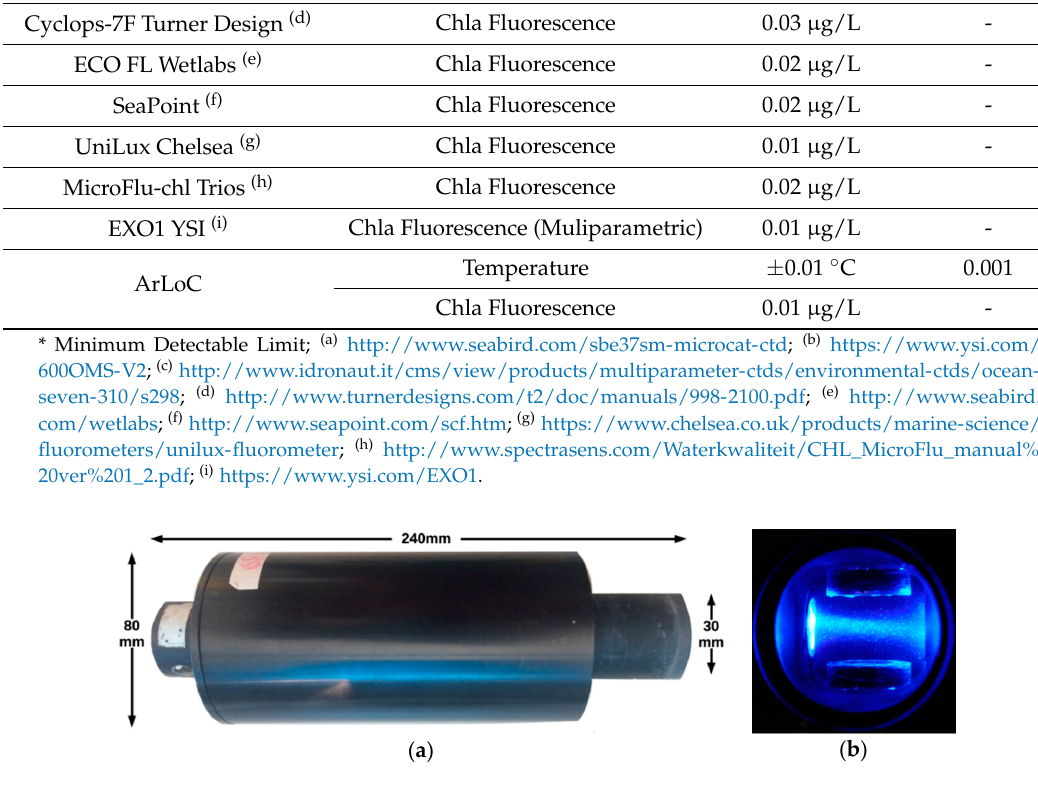
Figure 1. ( a ) ArLoC probe dimensions; ( b ) internal view of the measuring chamber with the excitation light source of chla fluorescence sensor.